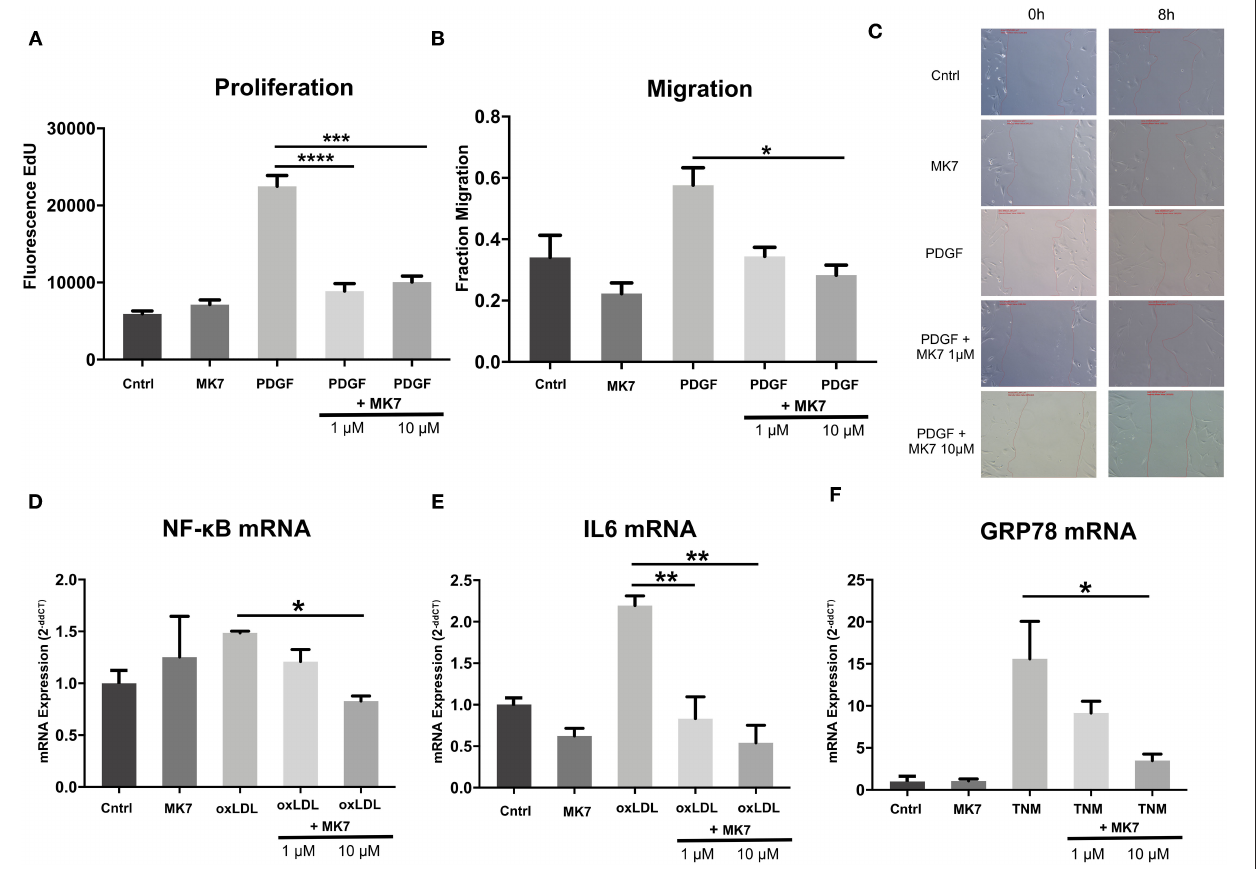
FIGURE 5 | Menaquinone-7 (MK7) alleviates HCASMC remodeling, inflammation and ER stress. (A) Proliferation of HCASMC untreated, treated with MK7 (1 µ M, 24h), PDGF (30ng/ml, 24h) or PDGF + MK7 (1 µ M or 10 µ M, 24h). Measured by an EdU fluorescence assay. n = 5. ( B) Migration of HCASMC after a wound–scratch assay, measured by microscopic visualization after 12h. Cells treated with MK7 (1 µ M, 24h), PDGF (30ng/ml, 24h) or PDGF + MK7 (1 µ M or 10 µ M, 24h). n = 4. (C) Representative pictures of cell migration 0 and 8h after scratch assay. (D, E) mRNA expression of the pro-inflammatory markers NF- κ B and IL-6 in HCASMC. Cells treated with MK7 (1 µ M, 24h), oxLDL (25ng/ml, 24h) or oxLDL + MK7 (1 µ M or 10 µ M, 24h). RNA expression was measured by using qPCR and quantified by the 2 − ddCT method. n = 3–4. (F) mRNA expression of the ER stress marker GRP78 in HCASMC. Cells were treated with MK7 (1 µ M, 24h), tunicamycin (TNM, 5 µ g/ml, 6h) or TNM + MK7 (1 µ M or 10 µ M, 24h). RNA expression was measured by using qPCR and quantified by the 2 − ddCT method. n = 3. Data are presented as the mean ± SEM; * p < 0.05, ** p < 0.01, *** p < 0.001, **** p < 0.0001. One-way ANOVA + Bonferroni’s multiple comparison test for (A-E)